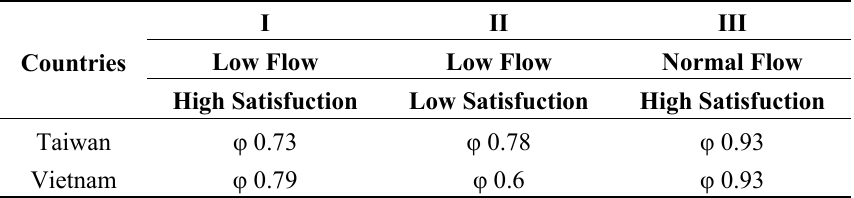
Table 5. Average of spray hole